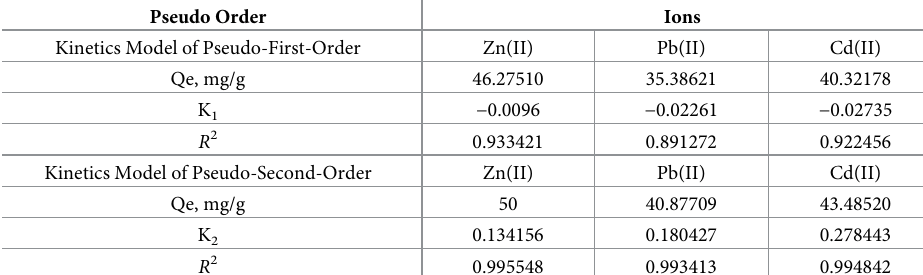
Table 1. The pseudo-first-order and pseudo-second-order kinetic parameters for sorption of Zn +2 , Pb +2 , and Cd +2 using SnCaAl 2 O 3 nanoadsorbent. Pseudo